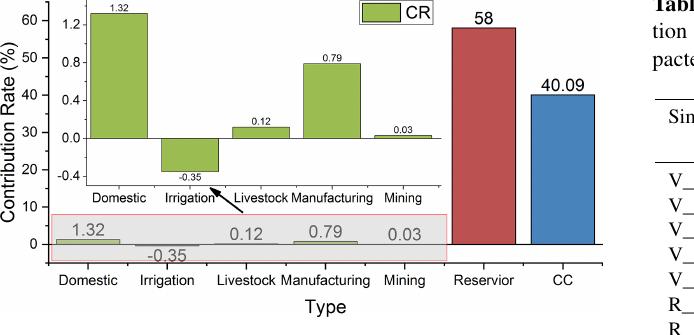
Figure 14. CR of domestic, irrigation, livestock, manufacturing, and mining water withdrawals and reservoir construction and CC to the streamflow changes at Yunjinghong station from 1961 to 2015.